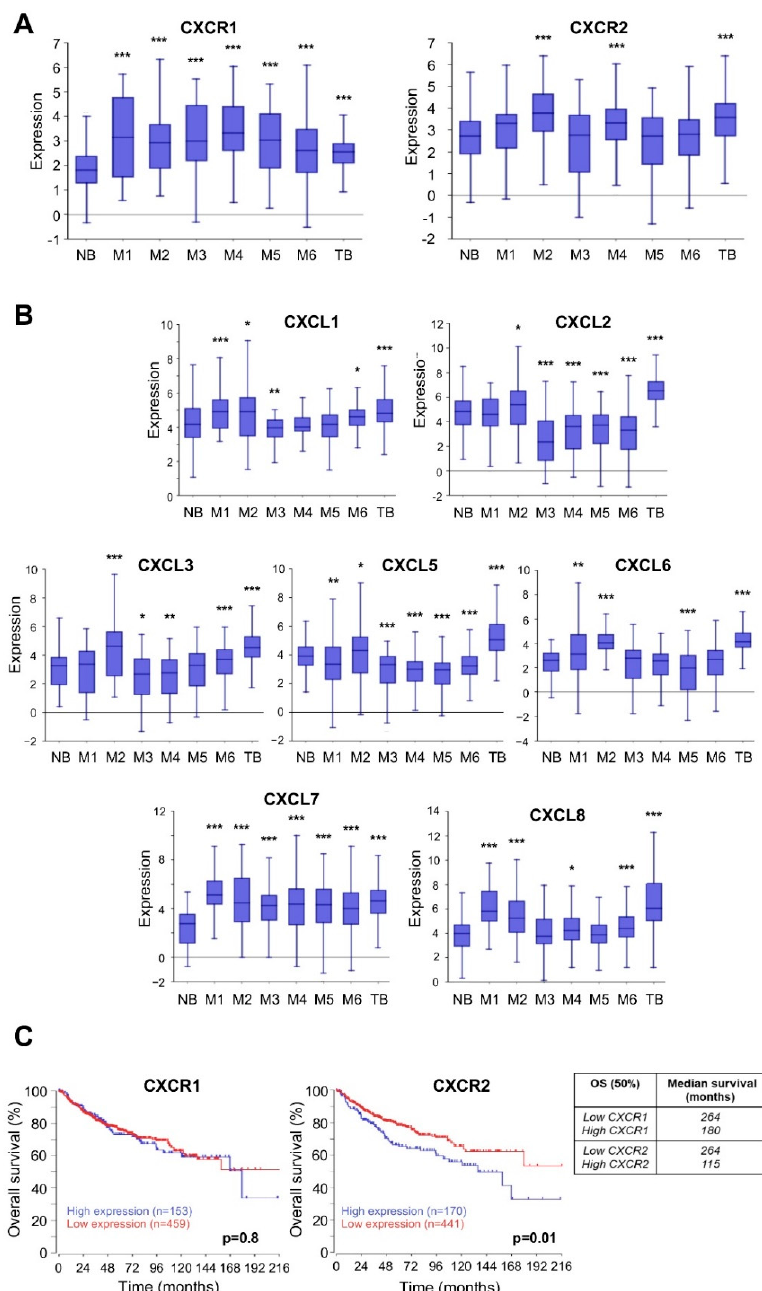
Figure 1. Members of ELR+CXCL/CXCR axis are overexpressed and associated with poor prognosis in MB patients. ( A , B ). Box-dot plot showing mRNA expression level of CXCR1, CXCR2, CXCL1, CXCL2, CXCL3, CXCL5, CXCL6, CXCL7, and CXCL8 (R2 platform) in healthy brain (Normal brain,